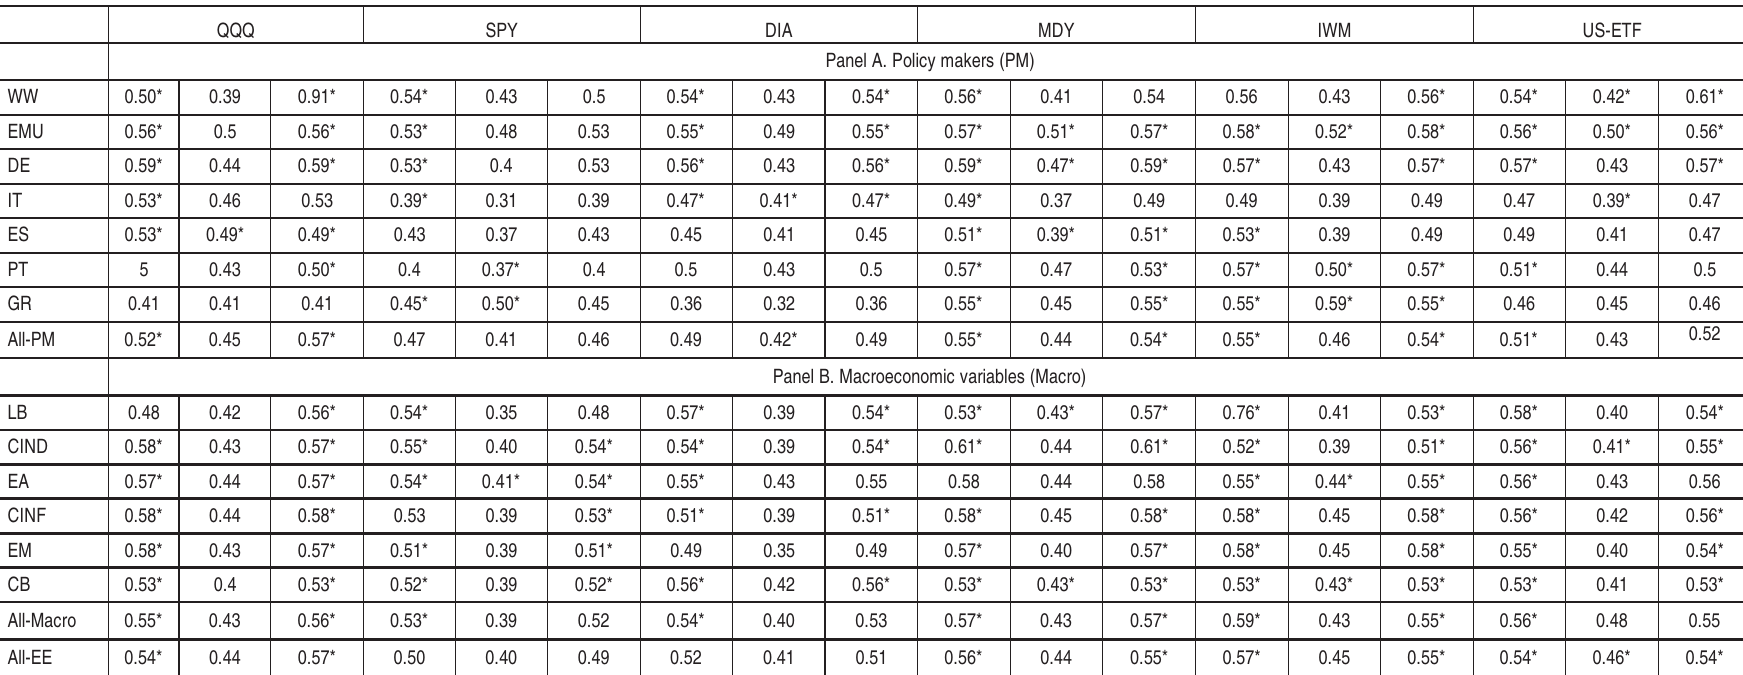
Table 13. Jump frequency criterion - US exchange traded funds (US-ETF)